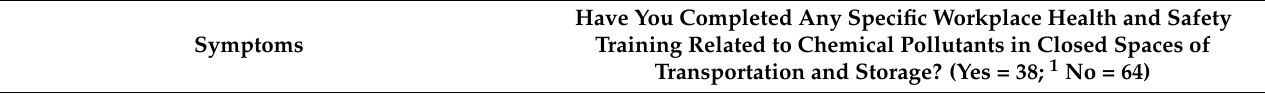
Table 9. Association between completing specific workplace health and safety training related to chemical pollutants and symptoms among warehouse workers at logistics